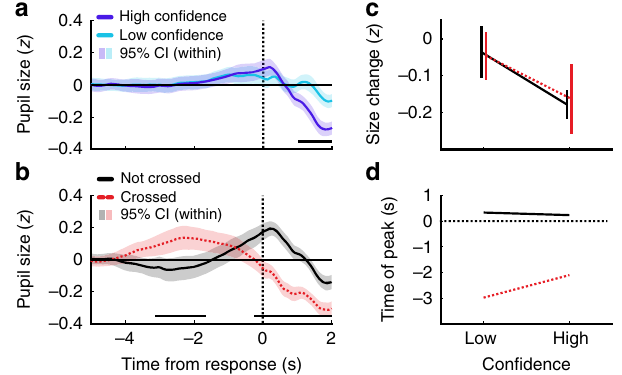
Fig. 6 Pupil response to con fi dence and boundary crossing. Average standardised pupil size in the Replay task across response-aligned (dashed vertical black line) time-windows, baselined to the average over − 5 to − 4 s. Shaded error bars show the 95% within-subjects con fi dence intervals. Differences between these lines were assessed using Wilcoxon sign rank tests, with signi fi cant clusters shown in the horizontal lines at the bottom of each plot. a Trials separated by con fi dence rating (high = 3 and 4, low = 1 and 2), with the black horizontal line showing signi fi cant differences. b Trials separated by whether it was likely that the observer ’ s covert bound was crossed, based on the fi tted parameters of the computational model, with the black horizontal line showing signi fi cant differences. c Average change in pupil size from the time of the response to 1s after the response for low- and high-con fi dence trials within crossed (red dashed) and not crossed (black) trials. Error bars show 95% within-subjects CI. d Time of peak pupil size in the low- and high-con fi dence trials within crossed (red dashed) and not crossed (black)